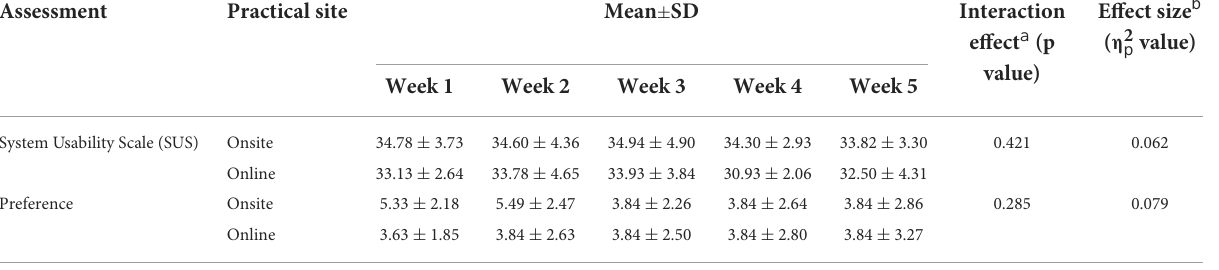
TABLE 5 Analysis of the SUS and preference